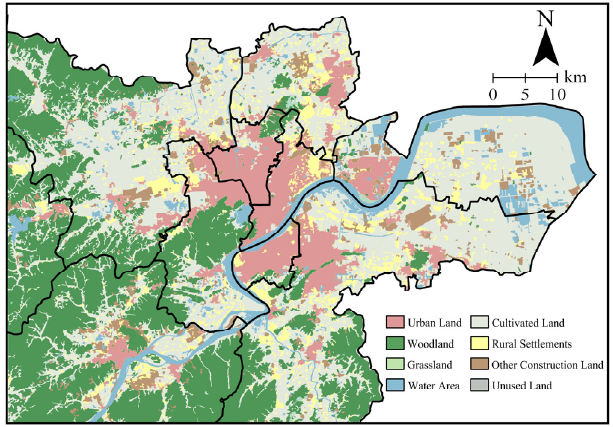
Figure 8. Land-use map of Hangzhou in